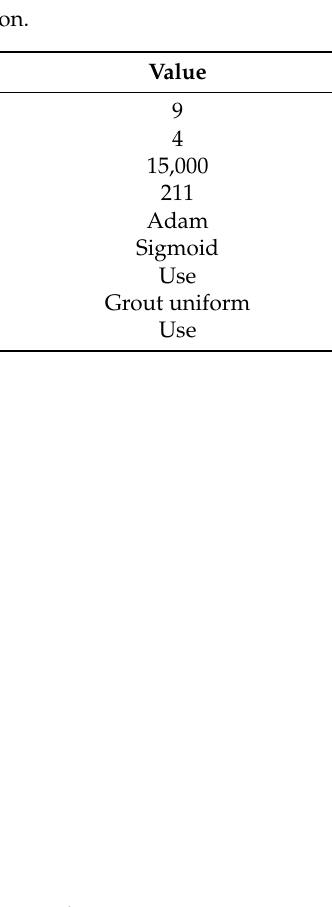
Table 8. The hyperparameters of the multilayer perceptron.